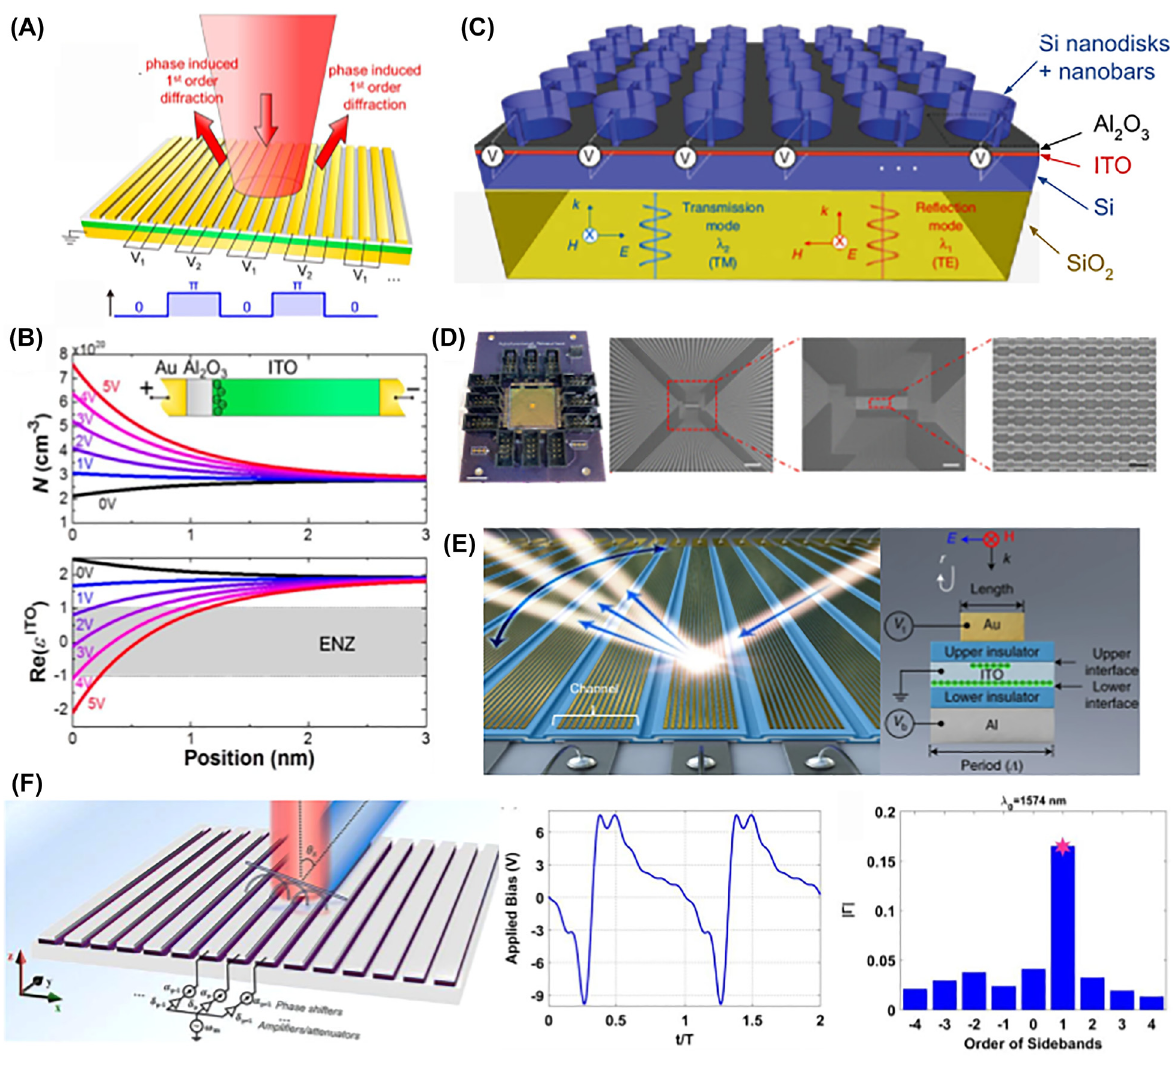
Figure 2: Active metasurfaces for beam